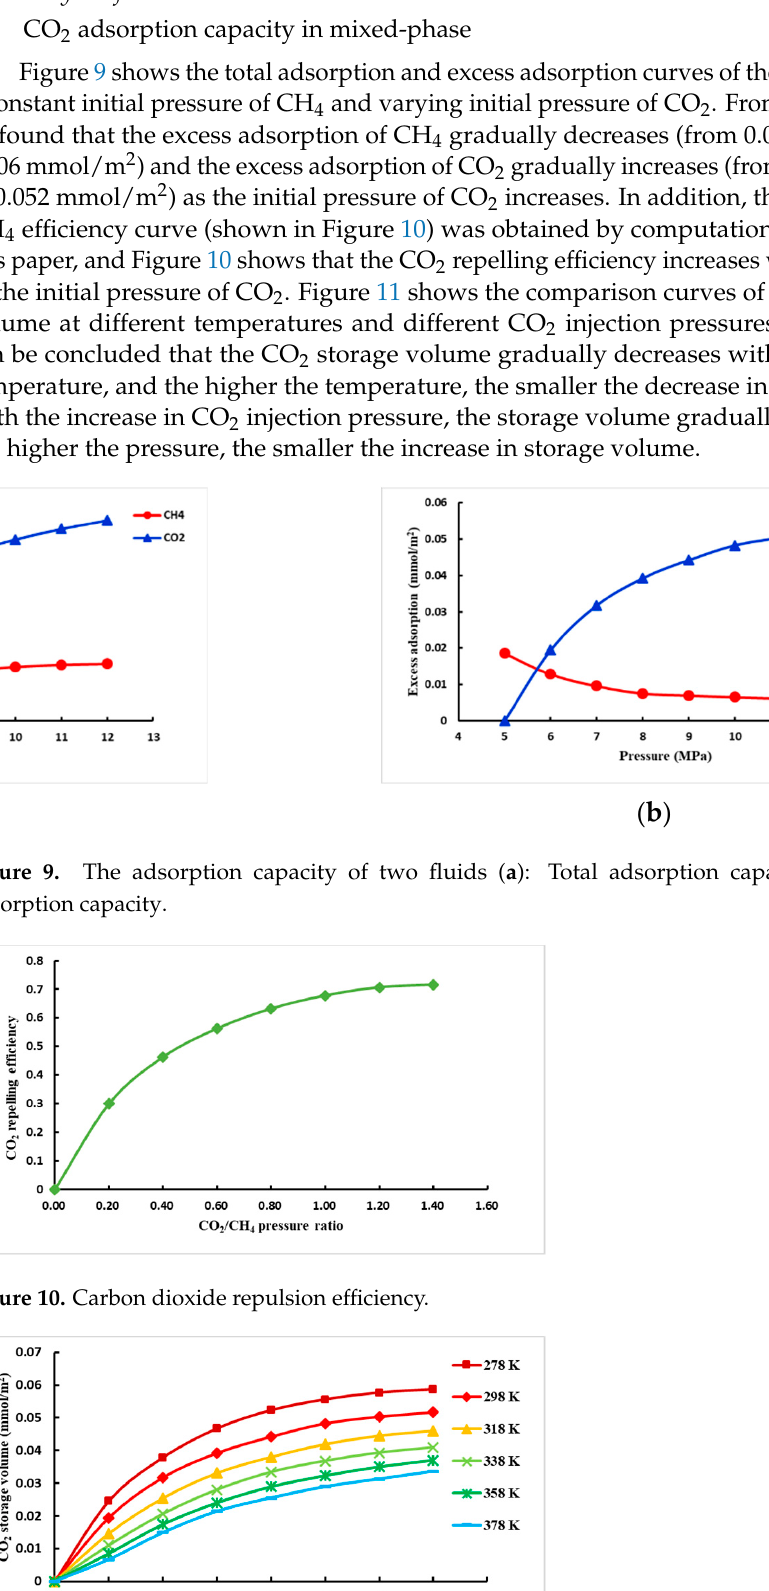
8 of 11 Figure 8. Pore size distribution curve of montmorillonite samples (a obtained by BJH method, b